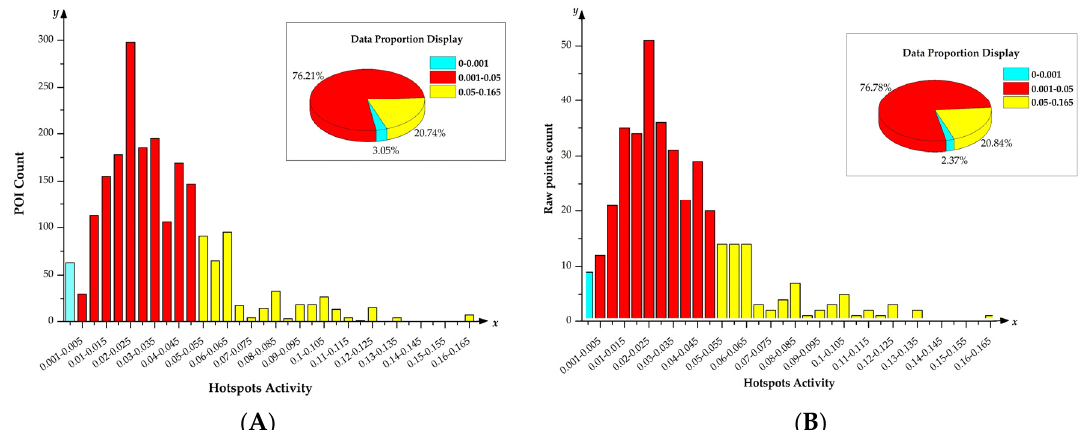
Figure 8. Statistical results for hotspot activities in different interval values. ( a ) Statistical results of POI count for different hotspot activity values. ( b ) Statistical results of the raw pixel count for different hotspot activity values. Note: The pie chart shows the proportions of POI data and raw pixels corresponding to hotspot activity value in three different ranges.